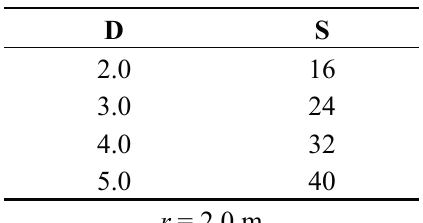
Table 1. Number of deployed IR sensors S used for experiments. It is related to the density of the sensors